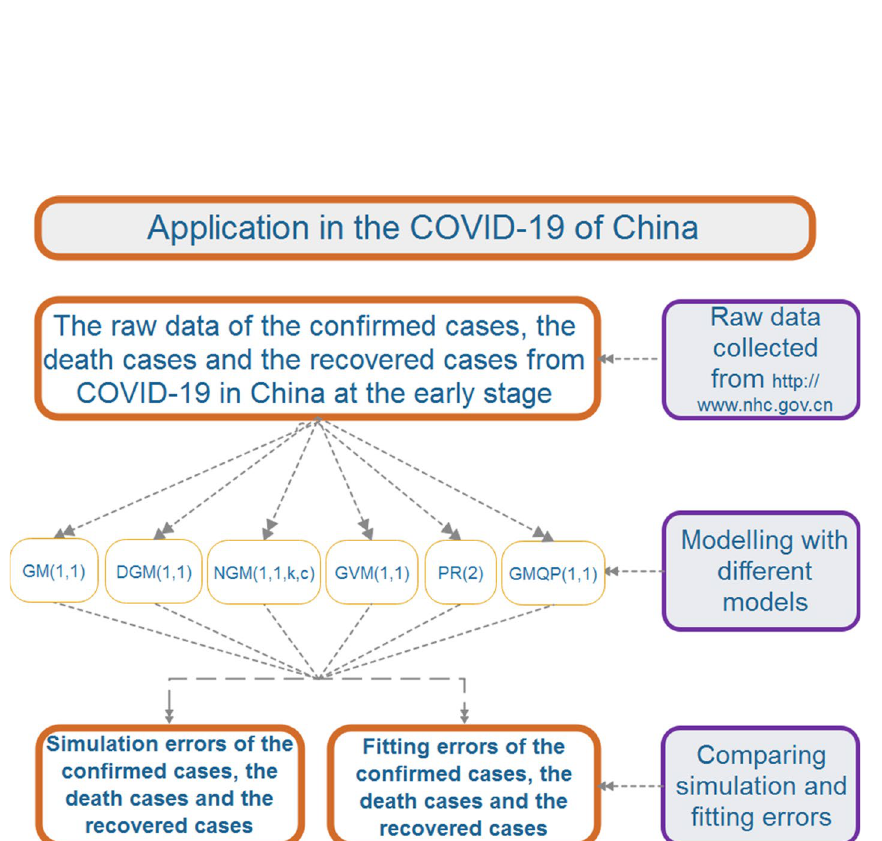
Figure 2. The structure of the application in the COVID-19 of